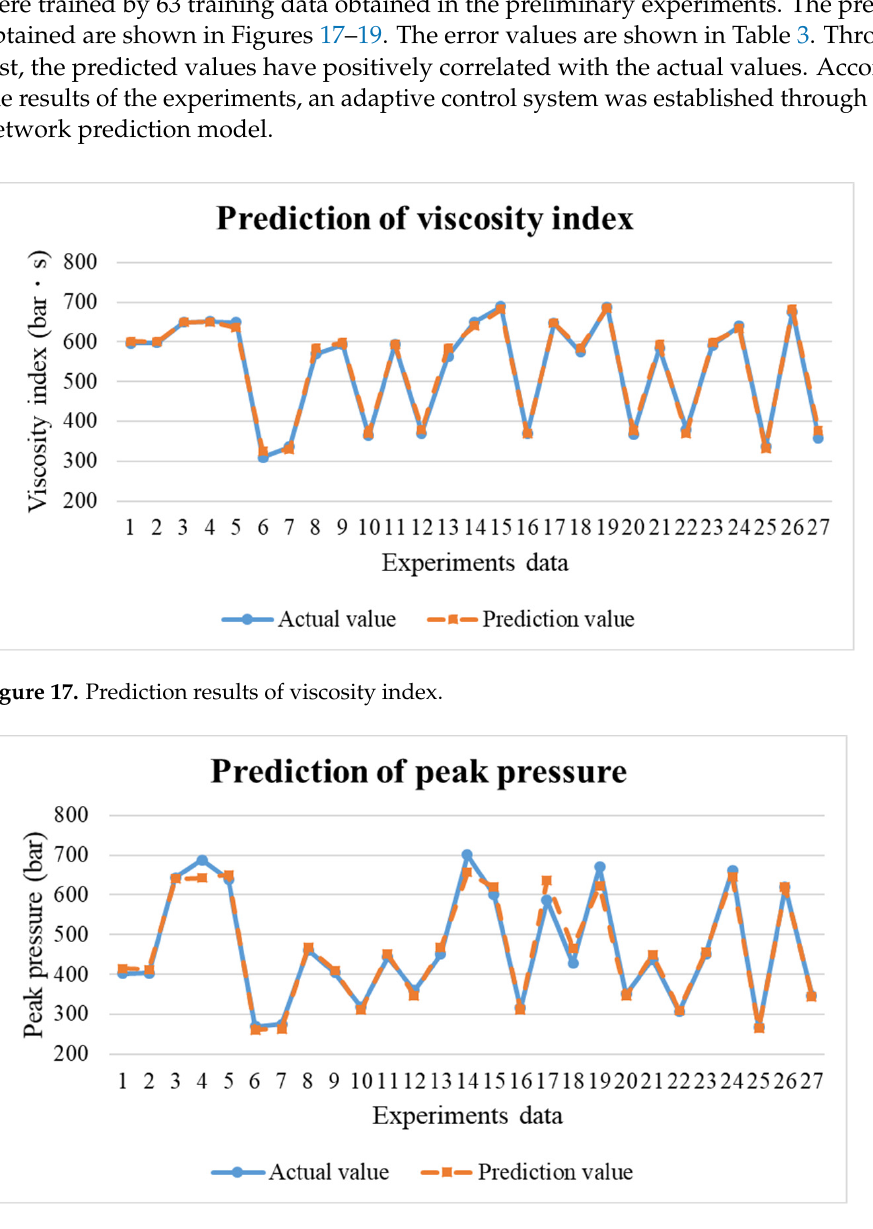
Figure 16. Relationship between part weight and injection speed.